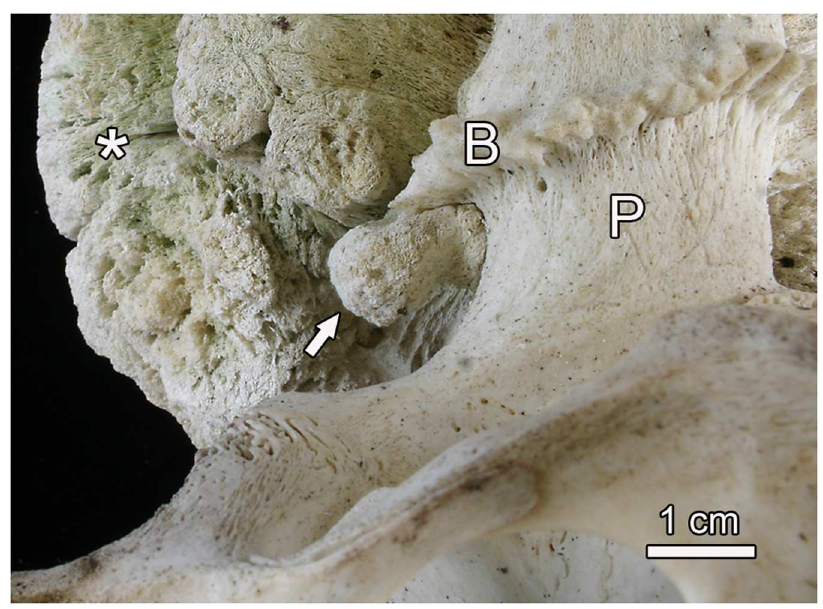
Fig 3. Small pedunculated exostosis (arrow) arising from the undersurface of the burr of the left antler of the white-tailed buck ( Odocoileus virginianus ). B: burr at the base of the left antler; P: pedicle; asterisk: portion of large exostosis arising from the left